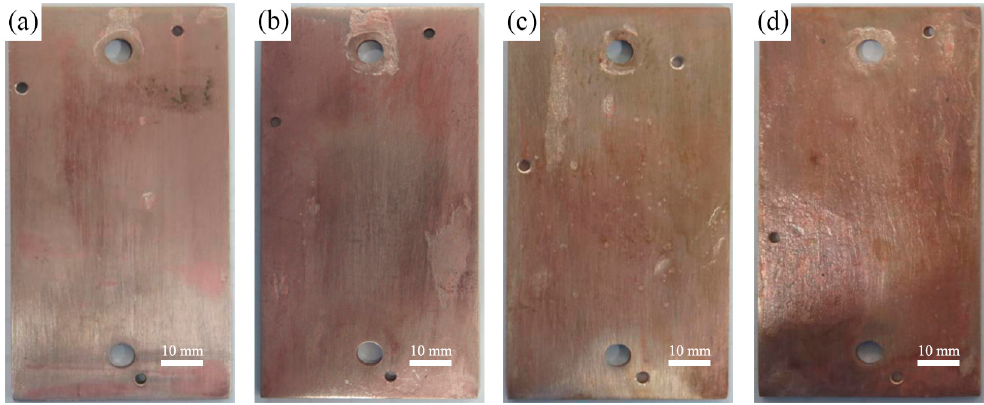
Figure 5. The macroscopic surface morphologies of Cu-Ni alloy after corrosion for ( a ) 7 d, ( b ) 14 d, ( c ) 28 d, and ( d ) 56 d (after removing the corrosion products).